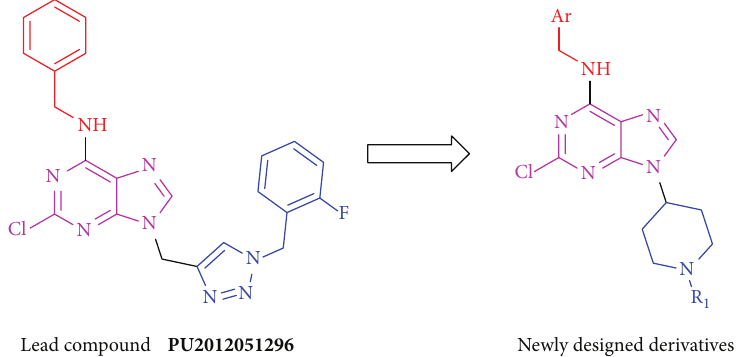
Figure 2: Thegeneral structureformula ofnewly designed 9-(1-(substituted-benzyl)piperidin-4-yl)-2-chloro-9 H -purin-6-aminederivatives.